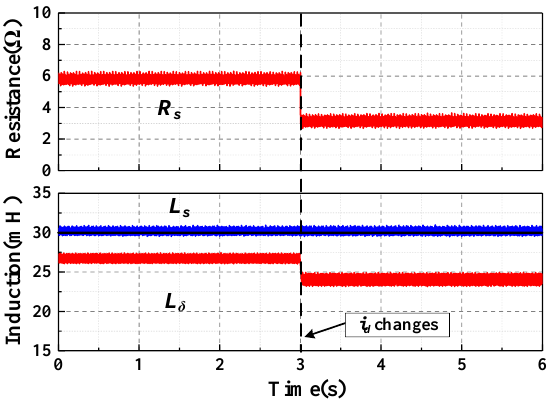
Figure 11 shows parameter identification results based on the voltages before and after nonlinearity compensation. When the reference voltage without compensation is used, there is a significant deviation between the parameter identification results and the nominal values in Table 3. Among them, R s is twice of that without compensation, which are 6 Ω and 3 Ω . The error of R s mainly comes from u 0 err . Figure 10, the u 0 err is close to u 0 . Therefore, the nonlinearity causes R s to be doubled before and after compensation according to (3). Moreover, L s is only related to u d , i q , and ω e when i d is 0. Since the d -axis nonlinear voltage is 0, L s does not change in Figure 12. L δ is related to u q . When u q becomes smaller, L δ also becomes closer to the nominal value.